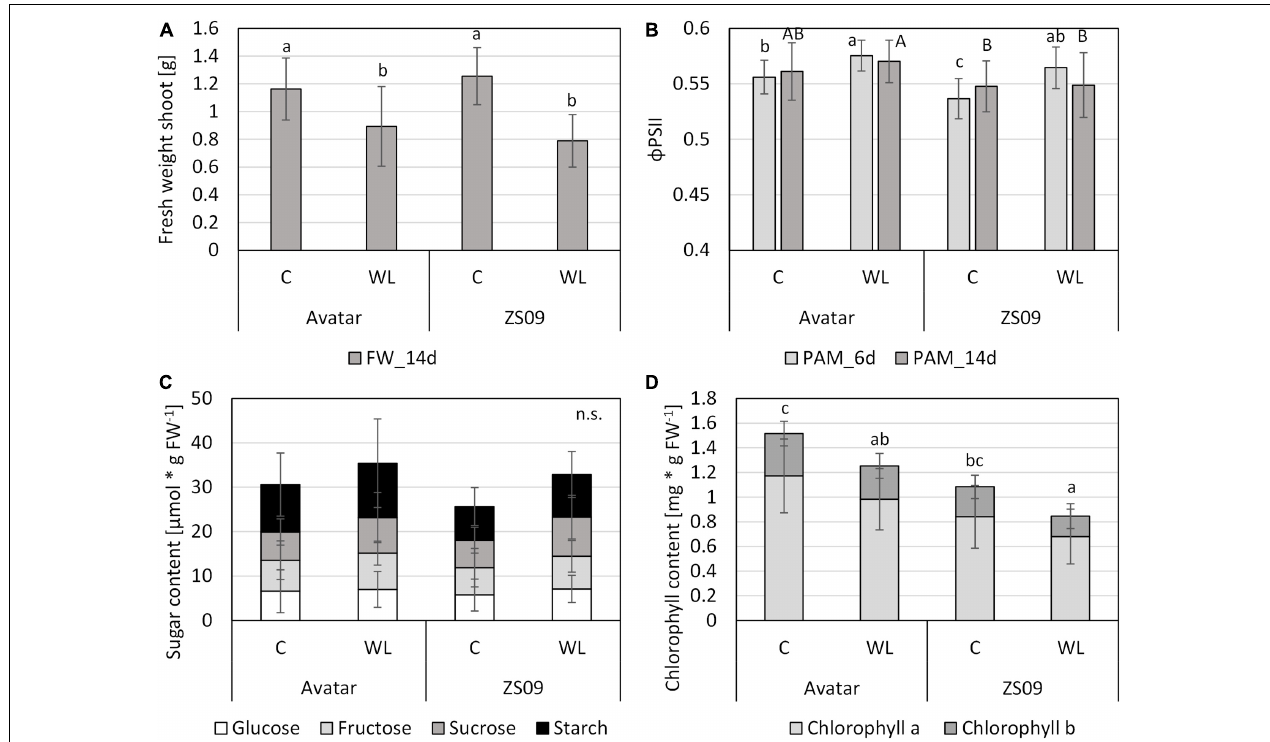
FIGURE 6 | Performance of two Brassica napus cultivars (Avatar, Zhongshuang 9) on soil under waterlogging with tap water (“WL”) for up to 14 days. At time of harvest, plants were 29 days old. (A) Fresh weight of shoots after 14 days of stress treatment compared with controls. Data are means ± SD of 3 experiments with 10 plants per experiment (n = 30). (B) chlorophyll fluorescence ( (cid:56) PSII) after 6 and 14 days of stress treatment compared with controls. Data are means ± SD of 3 experiments with 10 plants per experiment ( n = 30). (C) Content of carbohydrates [ µ mol ∗ g FW − 1 ] in leaves of after 14 days of stress. Data are means ± SD of 2 experiments with 6 plants per experiment ( n = 12). (D) Chlorophyll content [mg ∗ g FW − 1 ] in leaves of after 14 days of stress. Data are means ± SD of 2 experiments with 8 plants per experiment (n = 16). Different letters indicate significant differences (ANOVA and Tukey post hoc test, p < 0.05). n.s., not